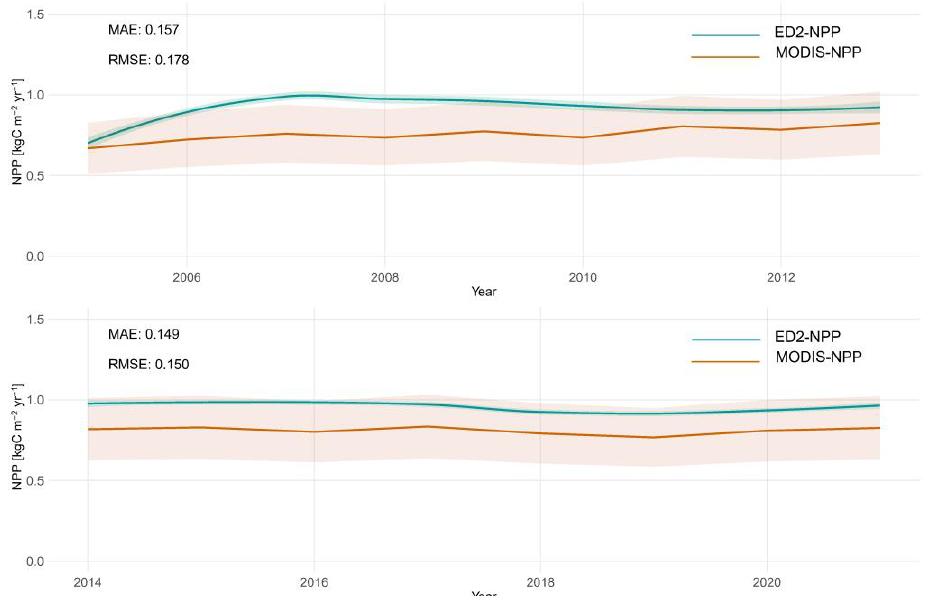
Figure 2. Annual ED-2.2 simulated NPP [kgC m − 2 yr − 1 ] vs. MODIS-NPP [kgC m − 2 yr − 1 ]. The green line is the annual model simulated NPP for an average of 10 plots, shaded as its confidence interval; the yellow line is the annual MODIS-NPP for an average of 10 plots, and the shading is mean relative error (23.58%).